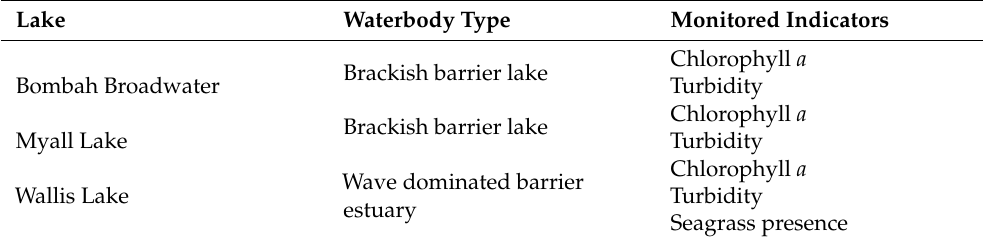
Table 1. Waterbody type classification of Bombah Broadwater, Myall Lake, and Wallis Lake [15], and the monitored estuary health assessment indicators